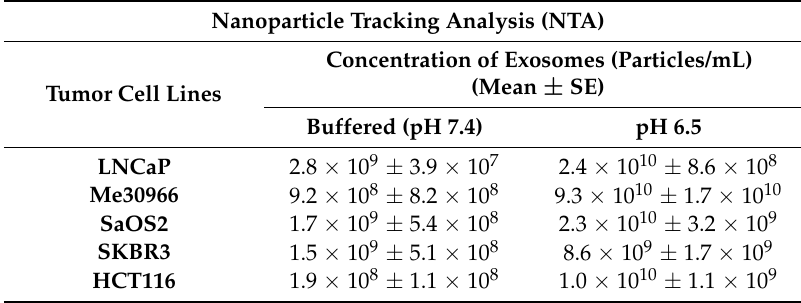
Table 2. Concentration of exosomes in tumor cells cultured in buffered (pH 7.4) and pH 6.5 conditions by Nanoparticle Tracking Analysis